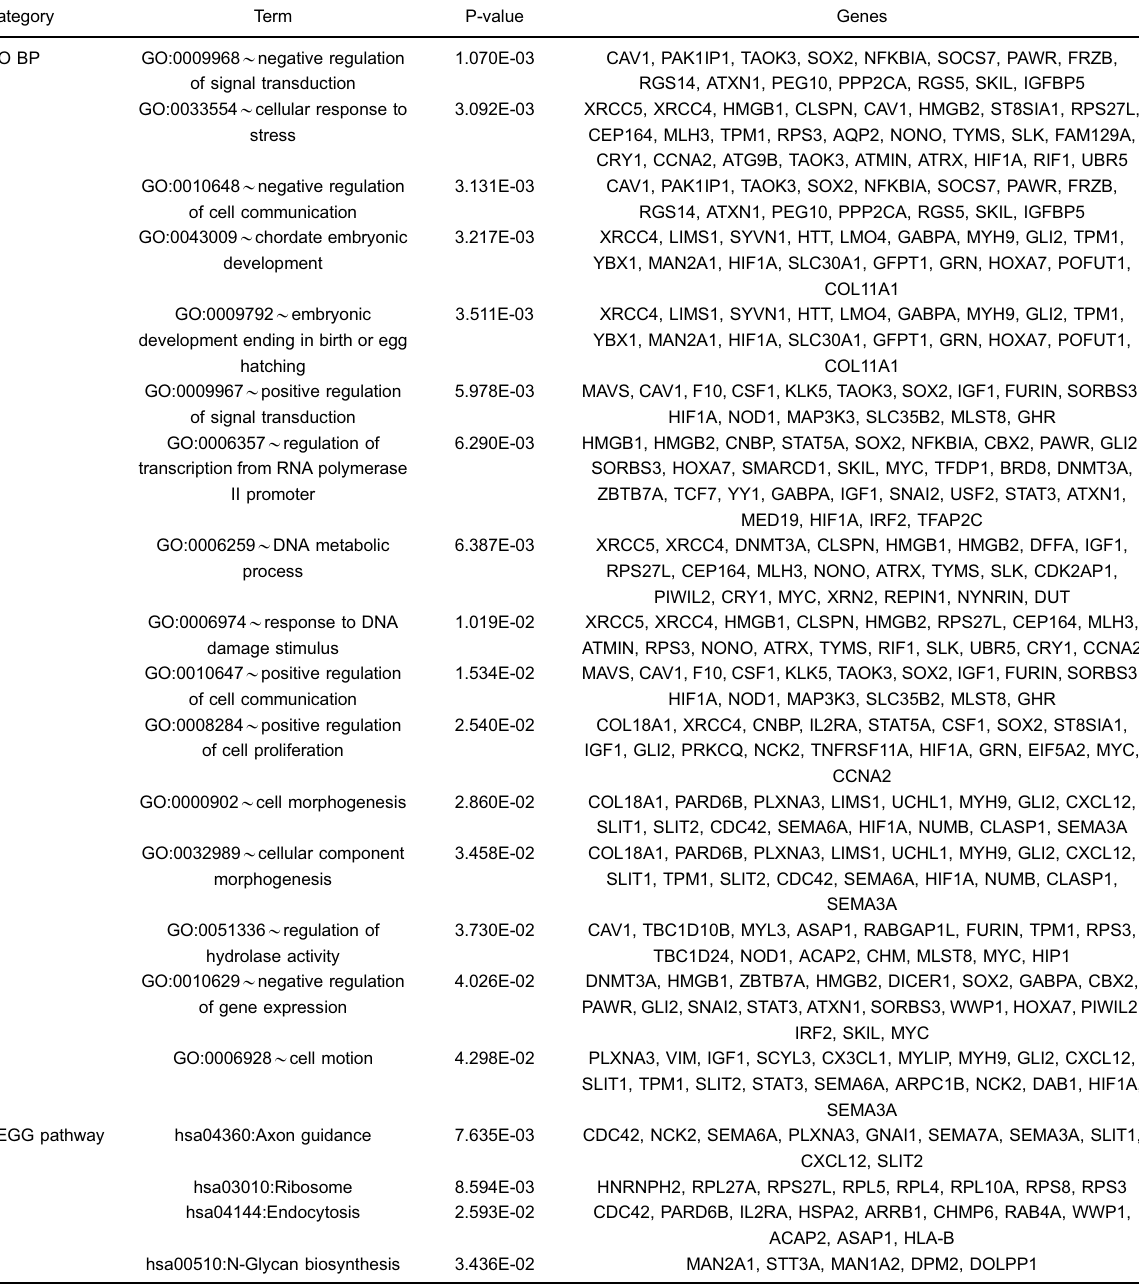
Table 1. Functional enrichment for genes in the ceRNA